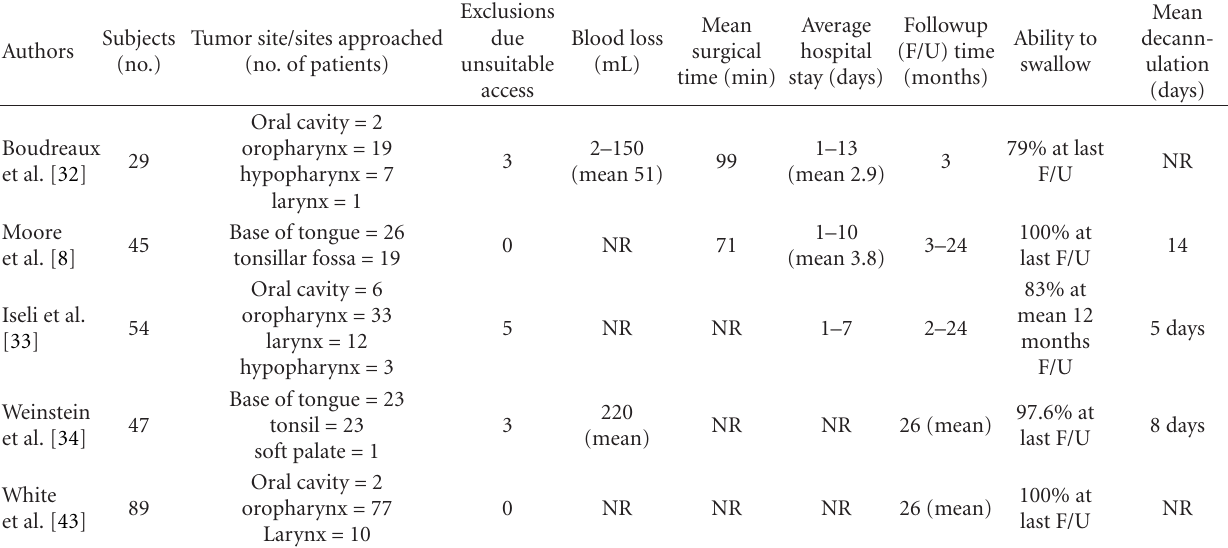
Table 1: Major clinical series in oncologic